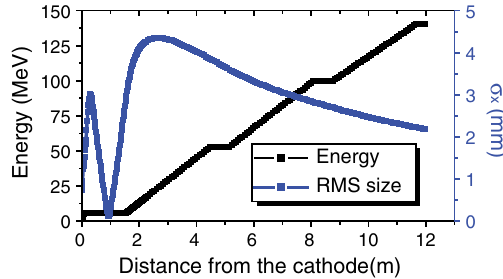
FIG. 8. Energy and transverse spot size of the beam along the SPARC beam